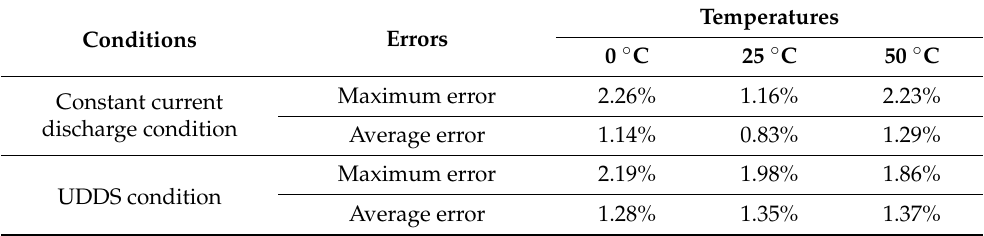
Table 3. Estimation error